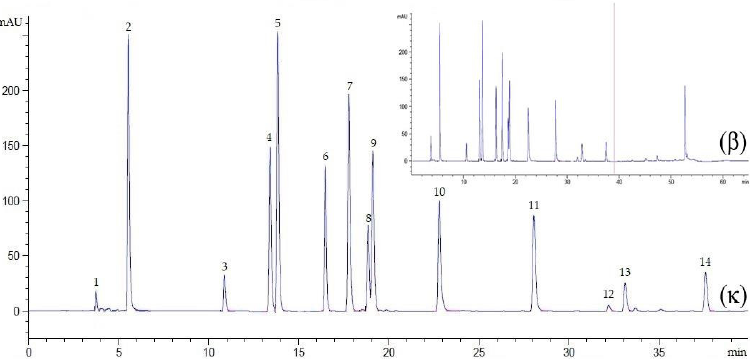
Figure 2. Chromatogram of an external standard mixture at λ = 272 nm, flow rate 0.9 mL/min, for 40 min ( κ ) and 65 min ( β ). Peak 1, ascorbic acid; 2, gallic acid; 3, catechin; 4, caffeic acid; 5, syringic acid; 6, rutin; 7, p -coumaric acid; 8, sinapic acid; 9, ferulic acid; 10, myricetin; 11, quercetin; 12, apigenin; 13, kaempferol; 14, eugenol.